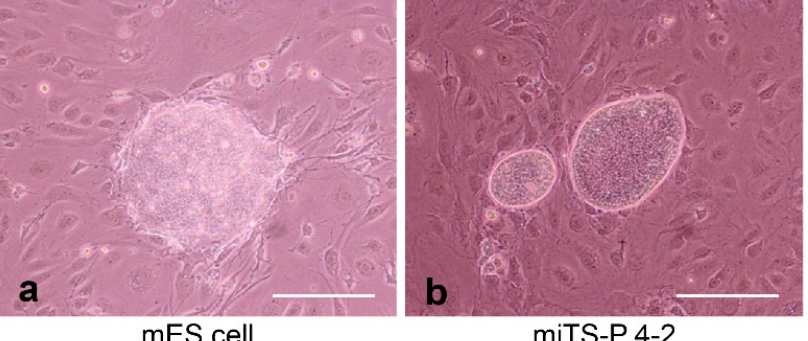
Figure 2. iTSCs (iTSC-P cells) generated from primary pancreatic cells isolated from non-obese diabetic (NOD) mice after transfection with an OSKM-expression vector. The resulting iTSC-P cells (miTS-P 4-2 in b) exhibit a cobblestone-like morphology, different from that of the mouse ESCs’ mole-like morphology (mES cells in a). We obtained these images from experiments performed exclusively for this review. Scale = 200 μ m.